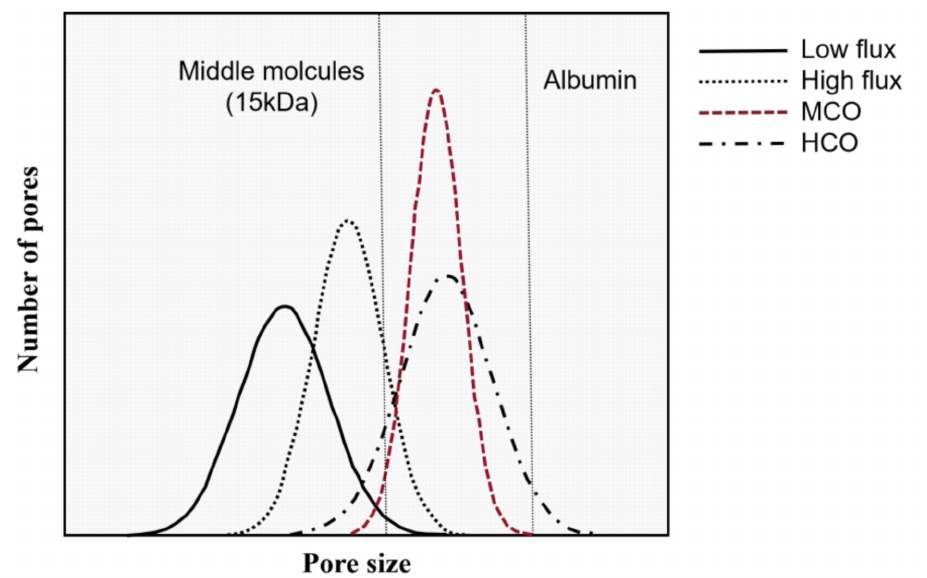
Figure 2. Schematic of pore size distribution in different types of membranes. As MCO